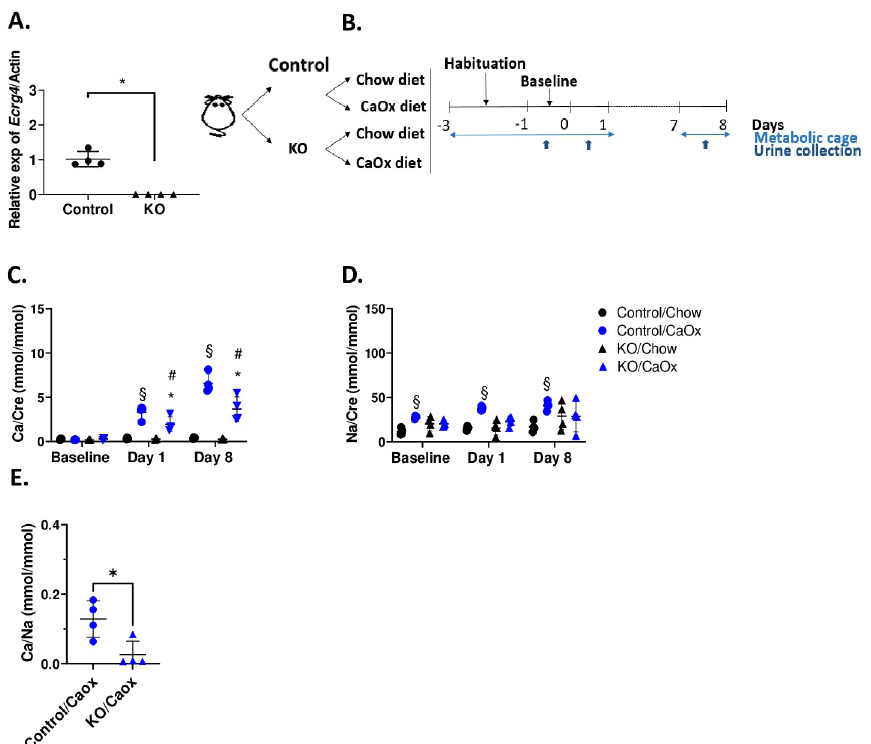
Fig 3. Ecrg4 KO male mice are resistant to induced hypercalciuria. (A) Ecrg4 mRNA expression in the kidney of Ecrg4 KO mice. P value was calculated using t-test. (B) Schematic representation of the experimental plan. Male mice were habituated in metabolic cages for 2 days. Then, control and Ecrg4 KO mice were exposed to either the regular chow diet or to a diet enriched in calcium (1.5%) and the oxalate precursor hydroxyproline (2%) (CaOx diet) for 8 days. The mice were housed individually in metabolic cages for urine collection at baseline, day 1 and day 8. (C) Increase in the urinary calcium-creatinine ratio in both control and Ecrg4 KO mice under CaOx diet. The ratios were calculated from the urine collected at baseline, day 1 and 8 under chow diet or CaOx diet. At 8 days of the CaOx diet, the Ecrg4 KO male mice had a significantly lower calcium-creatinine excretion compared to control mice. (D) Urinary sodium-creatinine ratio in both control and Ecrg4 KO male mice. (E) Urinary calcium/sodium ratio after 8 days of CaOx diet. Data are shown as individual points and mean ± SD (n = 4). For data B-D, p value was calculated using two-way ANOVA with Tukey correction for multiple comparisons. Stars indicate � p < 0.05 between control and Ecrg4 KO mice; § indicates p < 0.05 for comparison of control mice in the two different diets (chow vs. CaOx); # indicates p < 0.05 of Ecrg4 KO mice in the two different diets (chow vs. CaOx). (2%), further referred to as the CaOx diet (Fig 3B). Ecrg4 KO male mice fed the CaOx diet had a significantly lower fractional excretion of calcium compared to control mice fed the same diet, despite comparable calcemia and blood creatinine values (Table 2). Such finding was not observed in females (Table 3). Under the CaOx diet, urinary calcium/creatinine ratio was increasing between baseline and day 8 (Fig 3C). Interestingly, after 8 days of treatment, urinary calcium excretion of Ecrg4 KO male mice was significantly lower compared to control male mice fed the same diet (Fig 3C). As differences of sodium excretion was observed between the groups under CaOx diet (Fig 3D), the urinary calcium/sodium ratio was calculated (Fig 3E) and showed that the lower calciuria observed in Ecrg4 KO mice is independent of sodium. Female data are provided in supplemental material, but did not show difference in renal cal- cium handling between Ecrg4 KO and controls (S9–S11 Figs). Altogether, this data shows that Ecrg4 KO male mice have lower fractional excretion and lower calciuria than controls while exposed to the CaOx diet.